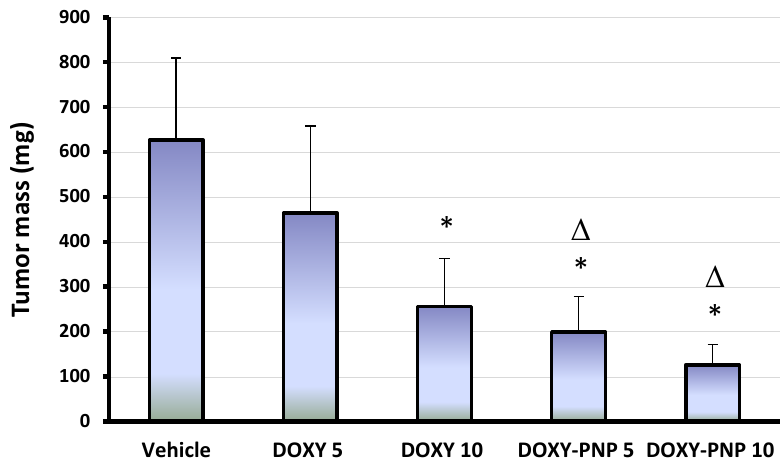
Figure 4. The mass of the solid tumors in the experimental groups. Column chart demonstrates the mean value of tumors for each mouse ± SD. Data were analyzed using multivariate ANOVA followed by Bonferroni’s post-hoc test at probability value < 0.05. *Versus vehicle and Δ versus DOXY 5 mg/kg, n = 6.